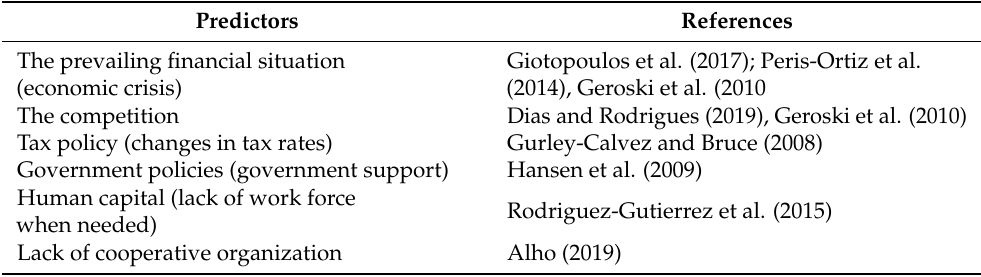
Table 1. Chosen non-organizational predictors of entrepreneurial success.